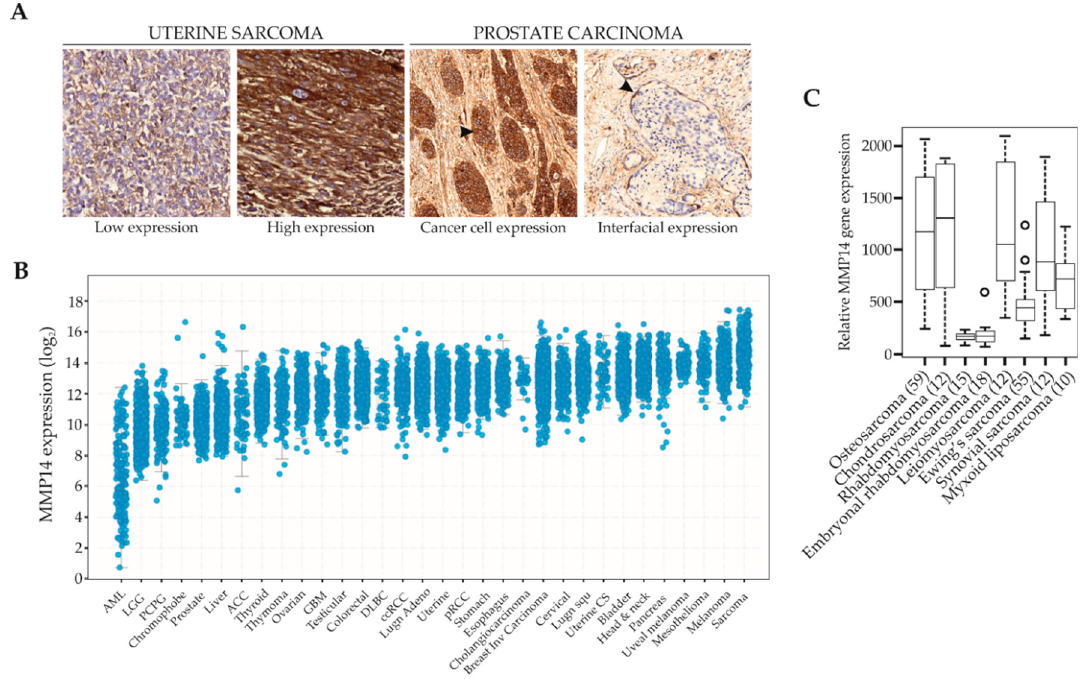
Figure 1. MMP14 expression in cancer. ( A ): Examples of MMP14 protein expression (in brown) in sarcoma (uterine sarcoma) and carcinoma (prostate carcinoma) tumors. Whereas in epithelial cancers, either the tumor cells or adjacent cancer associated fibroblasts can express MMP14, the mesenchymal sarcoma cells themselves express the protease. Arrowheads indicate high MMP14-expressing regions. ( B ): MMP14 gene expression in various cancer types based on The Cancer Genome Atlas program